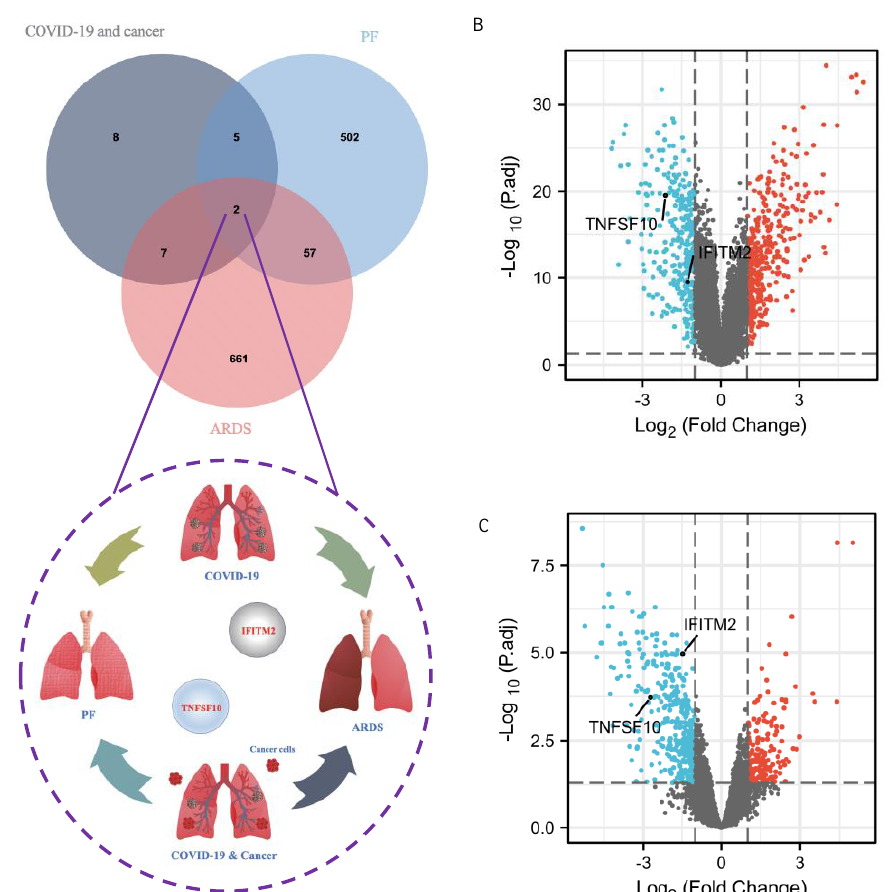
Figure 9. Identification of common DEGs among COVID-19 patients without and with cancer, ARDS and PF. ( A ) The Venn diagram suggested that TNFSF10 and IFITM2 are two very significant DEGs based on GSE164571, GSE147507, GSE40839 and GSE89953 datasets. TNFSF10 and IFITM2 were marked in the volcano plots from the GSE89953 dataset (ARDS) ( B ) and the GSE40839 dataset (PF) ( C ) (Adjusted p -value < 0.05, |log2FC|≥1).